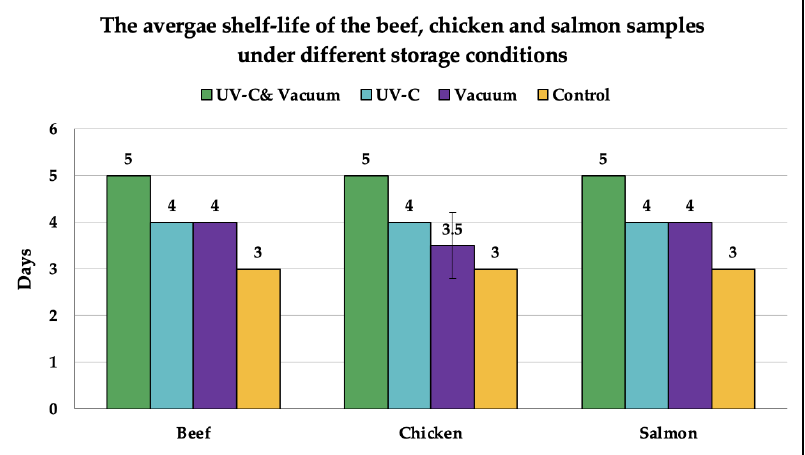
Figure 2 . The shelf-life of the beef, chicken, and salmon fillet samples stored under different condi- tions (days). The standard deviations of the two shelf-life measurement runs were calculated and used to derive error bars.